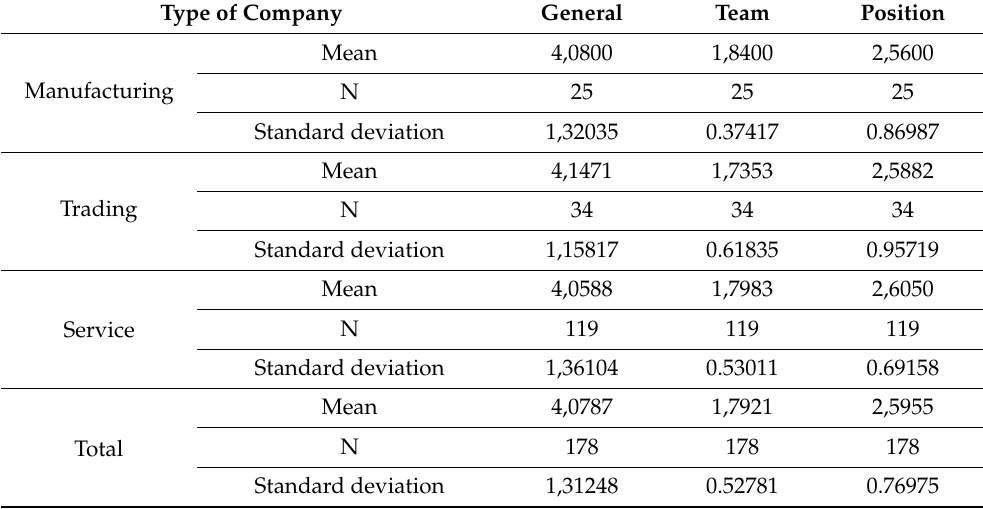
Table 1. The type of company and the type of onboarding